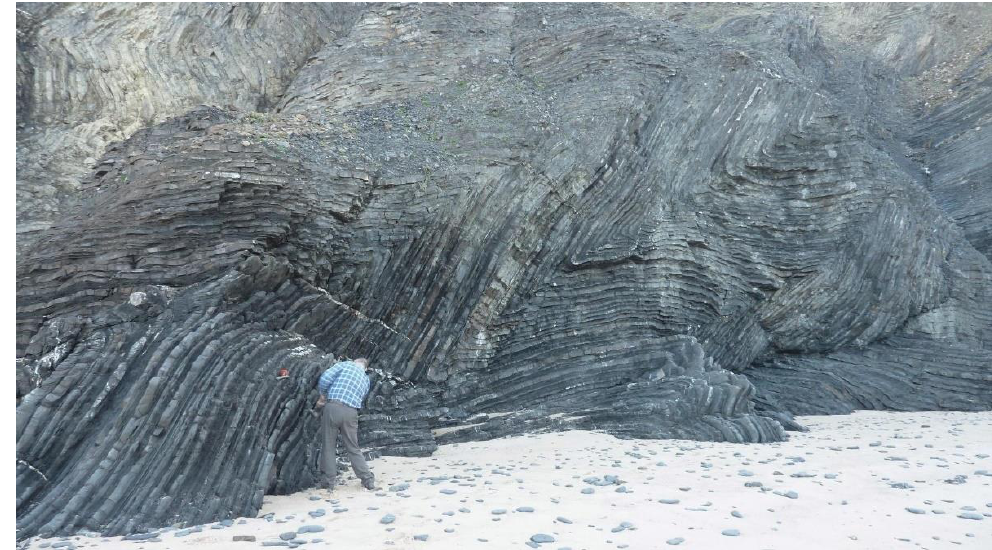
Figure 2. Outcrop of Brejeira Formation, highlighting the black shale sequence and high defor- mation.